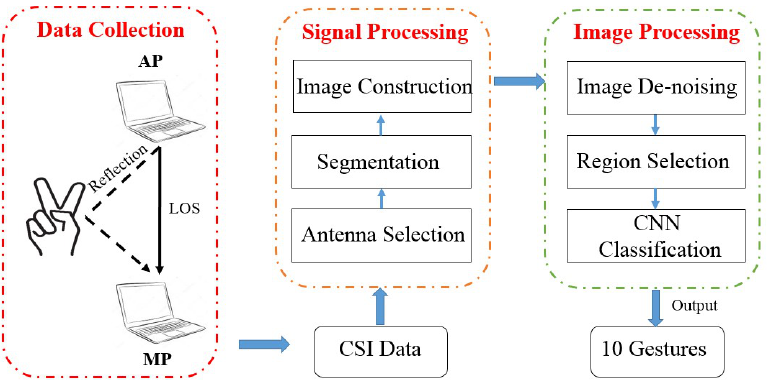
Figure 1. The system architecture of DeepNum .